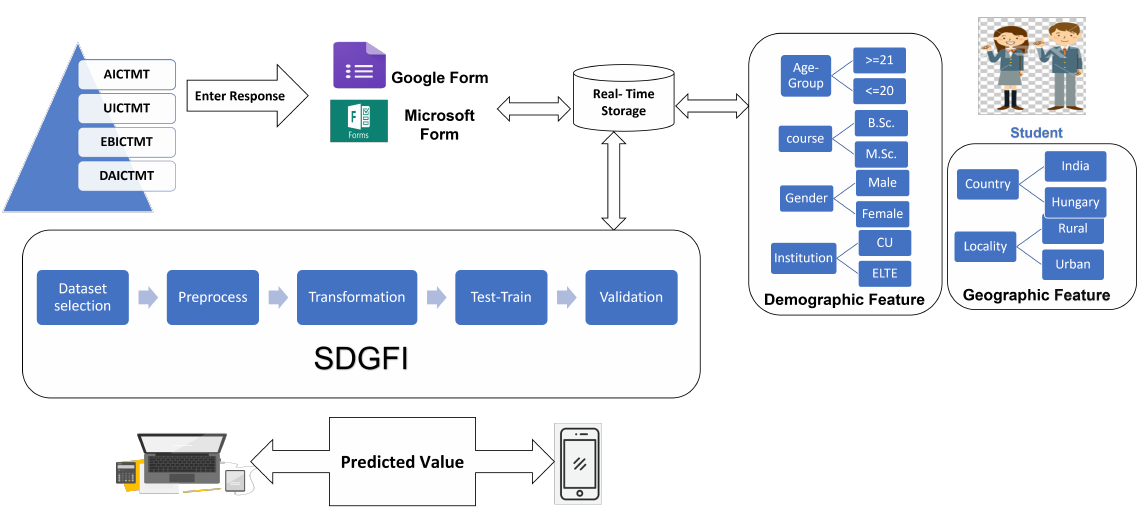
Figure 1. Student’s Demographic and Geographic Feature Identification